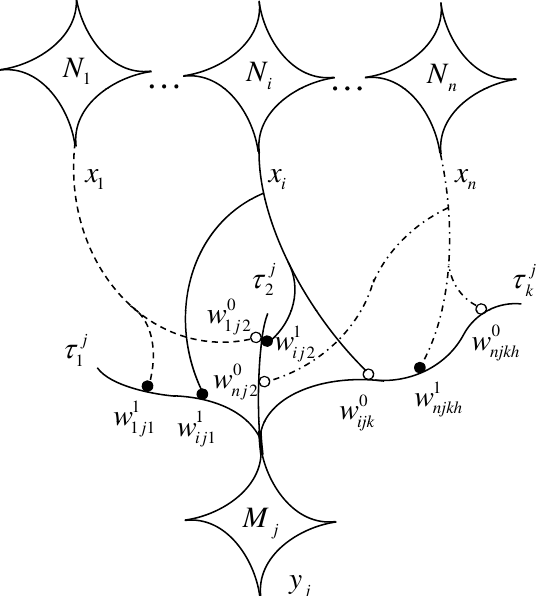
Figure 1. Illustration of neural axons and branches from the presynaptic neurons N i to the postsynaptic neuron M j . An inhibitory synaptic weight is shown as an open circle ( ◦ ), whereas an excitatory synapse is represented with a solid circle ( • ). The information value x i is transferred from neuron N i to the synaptic sites of the output neuron M j . Stemming from presynaptic neurons, boutons of axonal fibers communicate with the synaptic sites on dendritic branches τ j of M j k